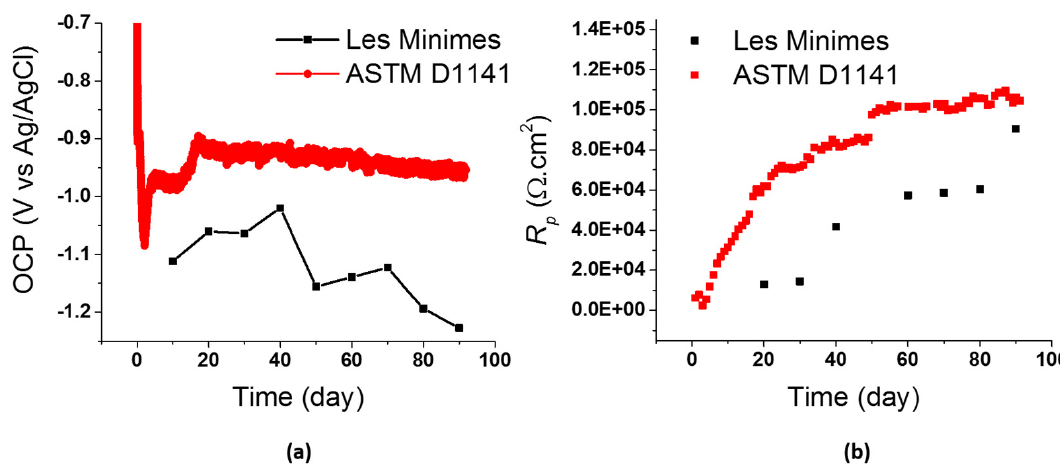
Figure 10. ( a ) OCP and ( b ) LPR data of TS AA1050 with 5% of surface area defect immersed in artificial seawater ASTM D1141 (lab conditions) and a real marine environment (Les Minimes, France).